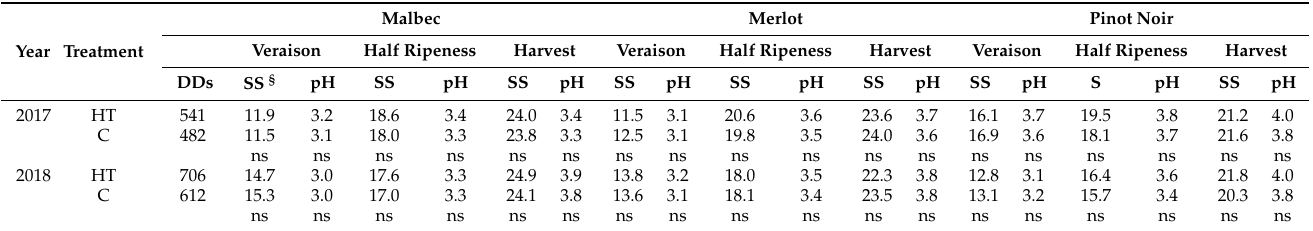
Table 1. Accumulated degree-days (DDs) and pH and soluble solids content ( ◦ Brix) in berries of Malbec, Merlot, and Pinot Noir plants grown under increased temperature (High temperature, HT) and natural conditions (Control, C), for three phenological stages (veraison, half-ripeness, harvest) in seasons 2017 and 2018. Values are means of four replicates. ns, no statistical difference ( p < 0.05) between HT and C, according to Kruskal Wallis test.